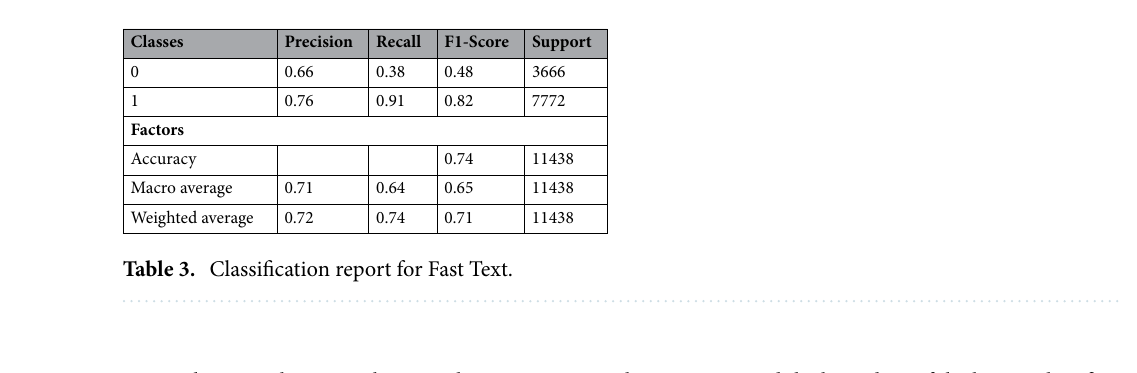
Figure 12. FastText plus LSTM and Multi-channel CNN ( a ) Model accuracy FastText plus LSTM ( b ) Model loss FastText plus LSTM ( c ) Confusion matrix FastText Multi-channel CNN.